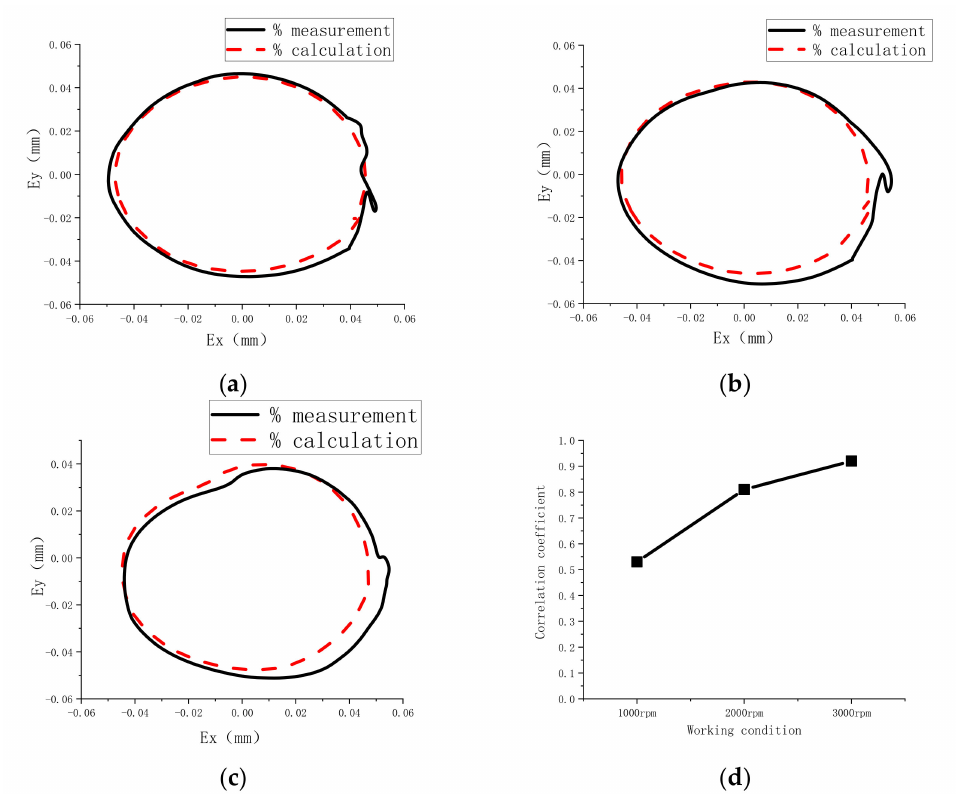
Figure4. Theaxisorbitsofthetestsandcalculationsatdi ff erentspeeds: ( a )Measurementandcalculation results at 1000 r / min; ( b ) Measurement and calculation results at 2000 r / min; ( c ) Measurement and calculation results at 3000 r / min; ( d ) Correlation coe ffi cient of calculation and measurement results at di ff erent